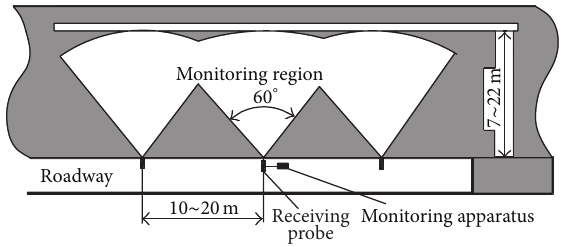
Figure 7: Monitoring region of electromagnetic radiation [7].